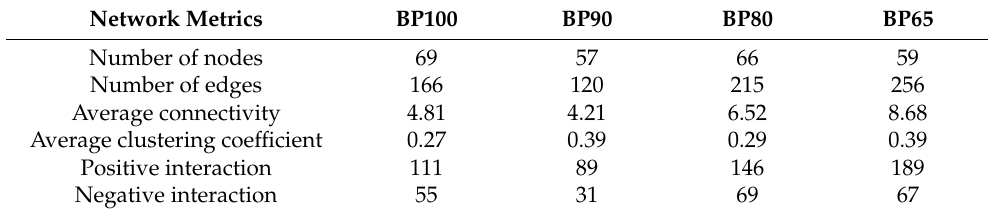
Table 1. Microbial co-occurrence network properties in different